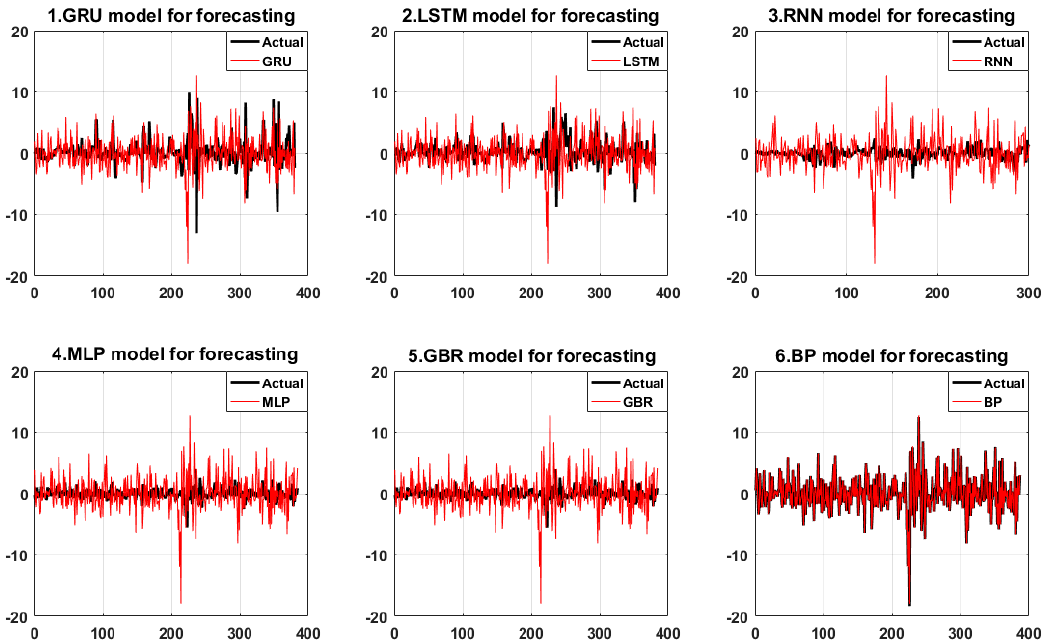
Figure 6. The forecasting performance of the proposed and benchmark models without considering the feature of time-varying, high-order moment.